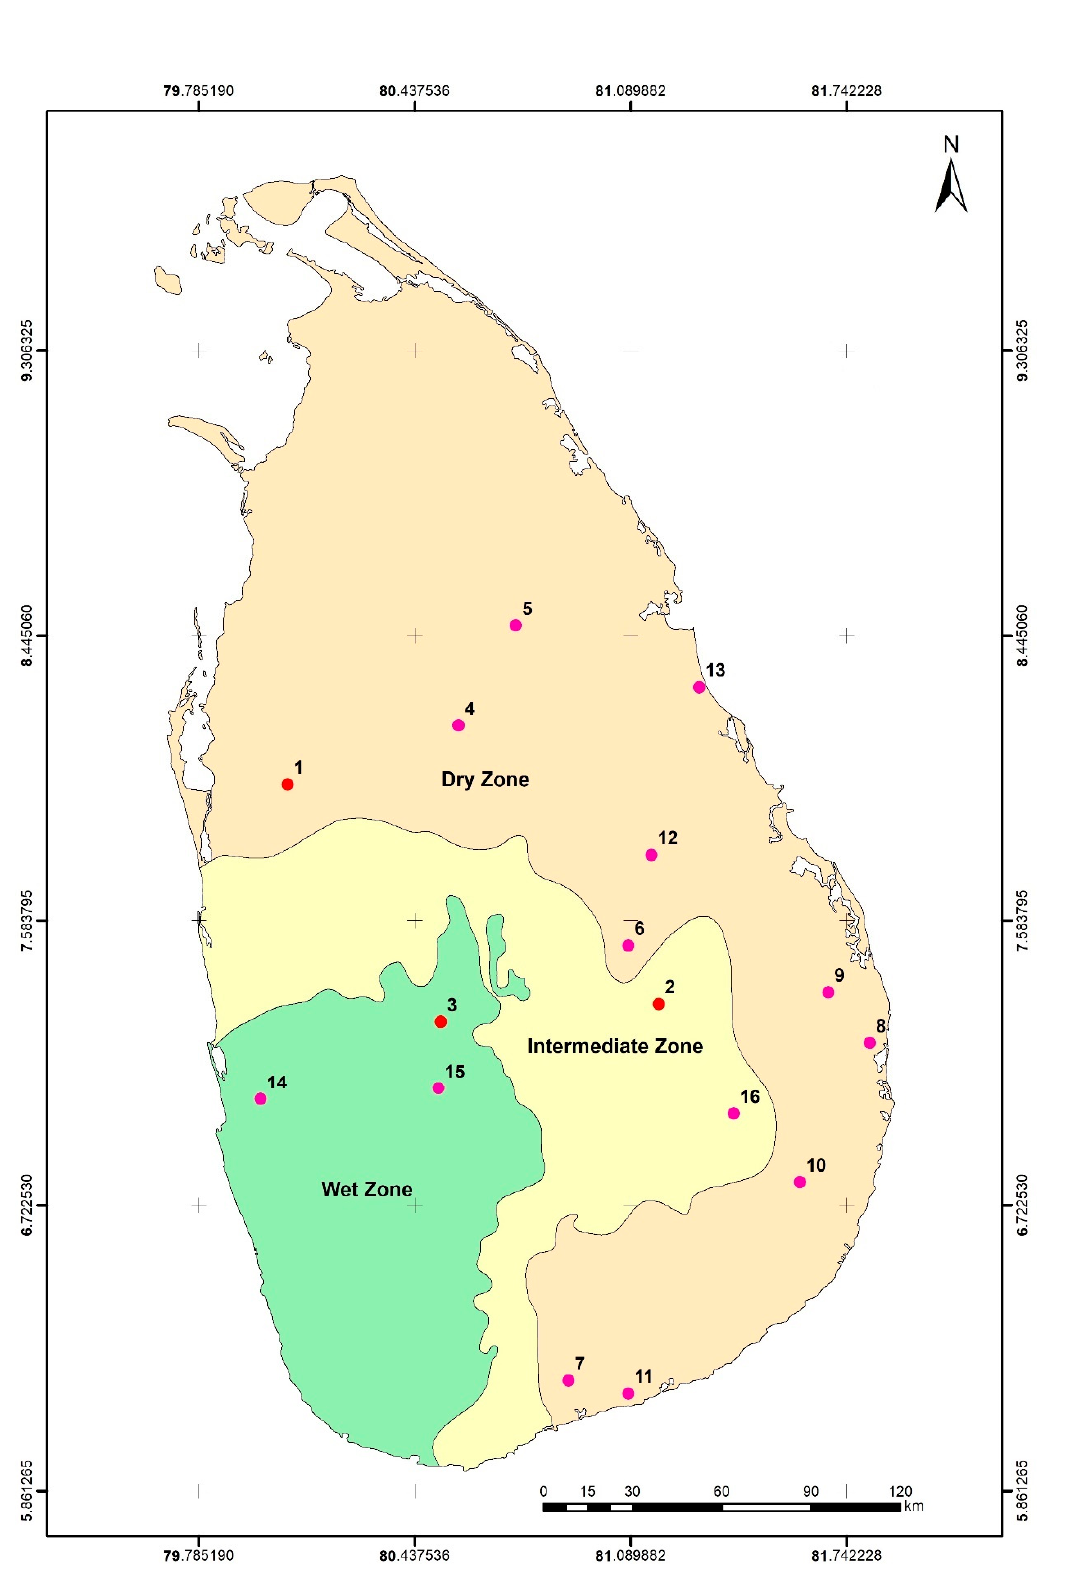
Figure 1. A map of Sri Lanka showing the study sites and climatic zones defined based on the mean annual rainfall